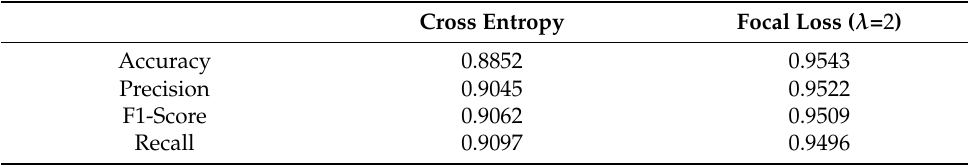
Table 5. Cross entropy and Focal Loss function performance.